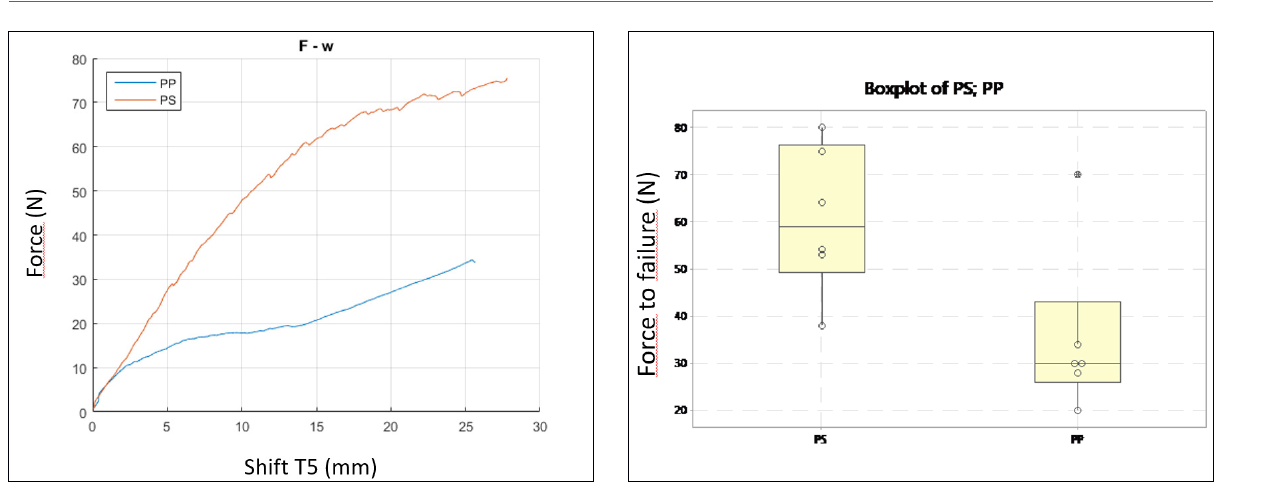
Fig. 8. Results for specimen 6 loading c. Fig. 9. Force to failure of fixation loading c.